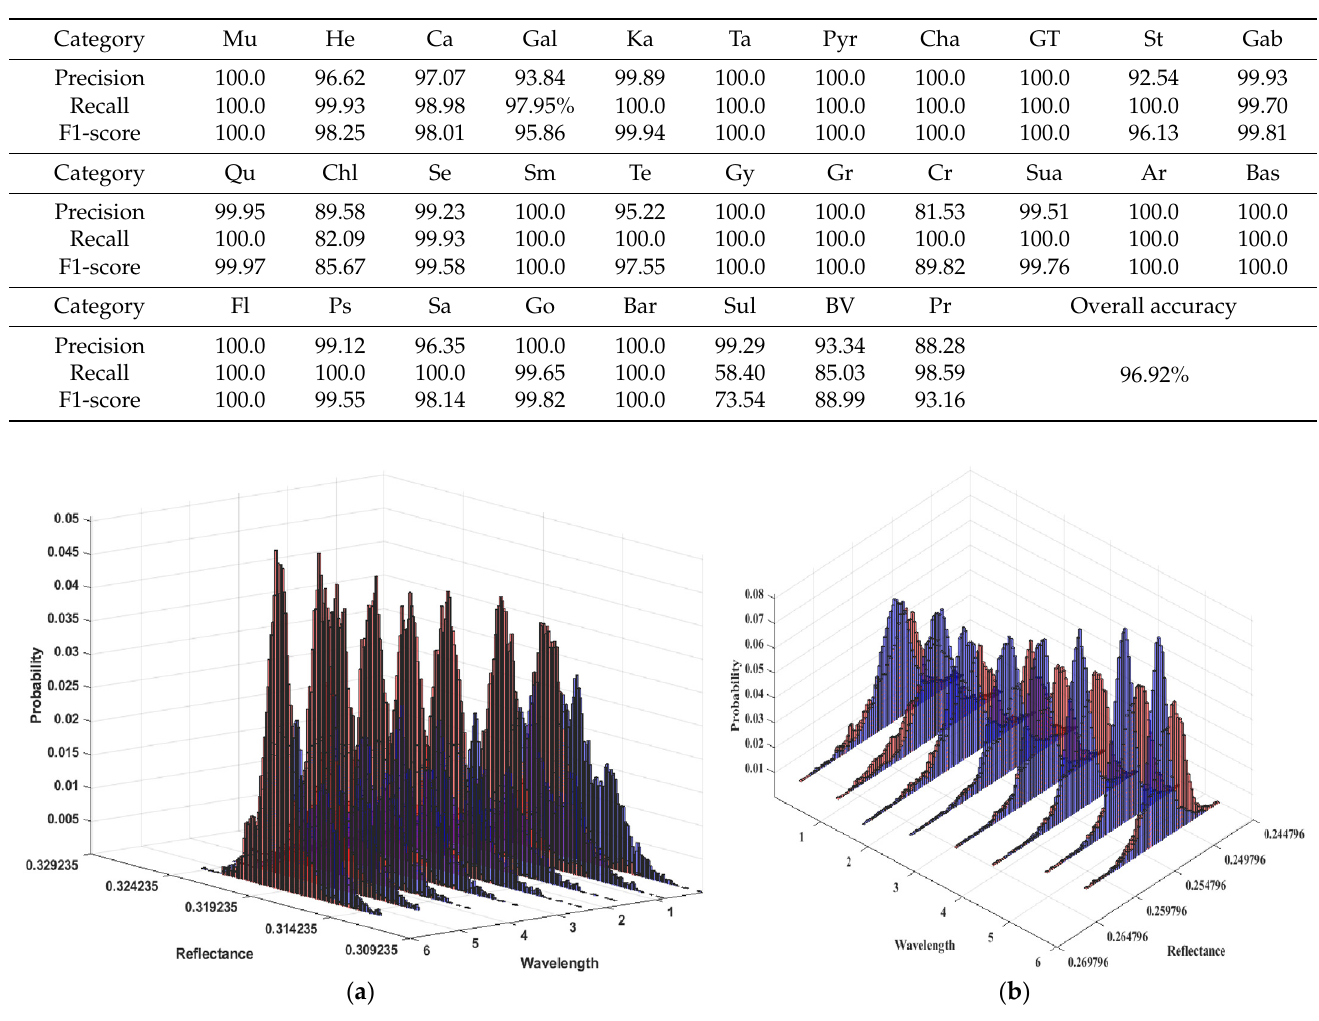
Figure 4. Spectral analysis of some wrong classification examples. The bars are rendered in different colors according to different categories. ( a ) Crystal–sulfur. ( b ) chlorite–saponite.